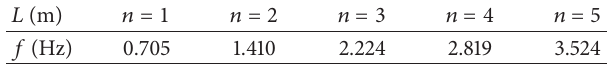
Table 1: The first five principal frequencies of the slime rod.